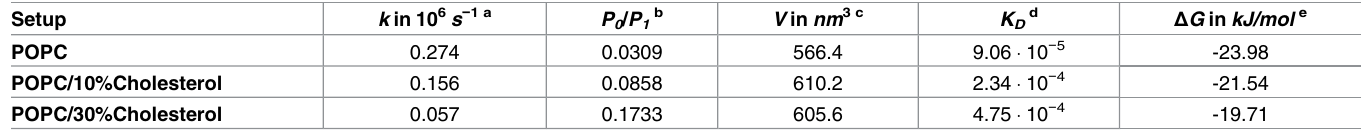
Table 3. Reaction rate constants, dissocation constants as well as binding free